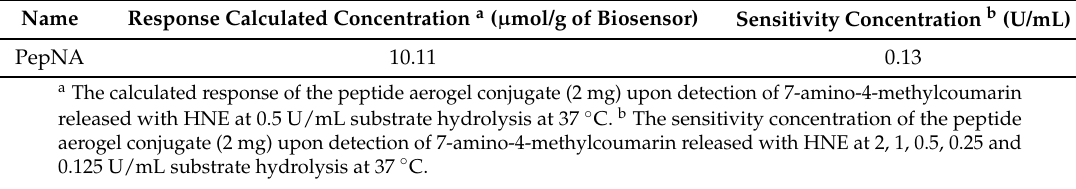
The response calculated concentration and sensitivity concentration of the peptide aerogel